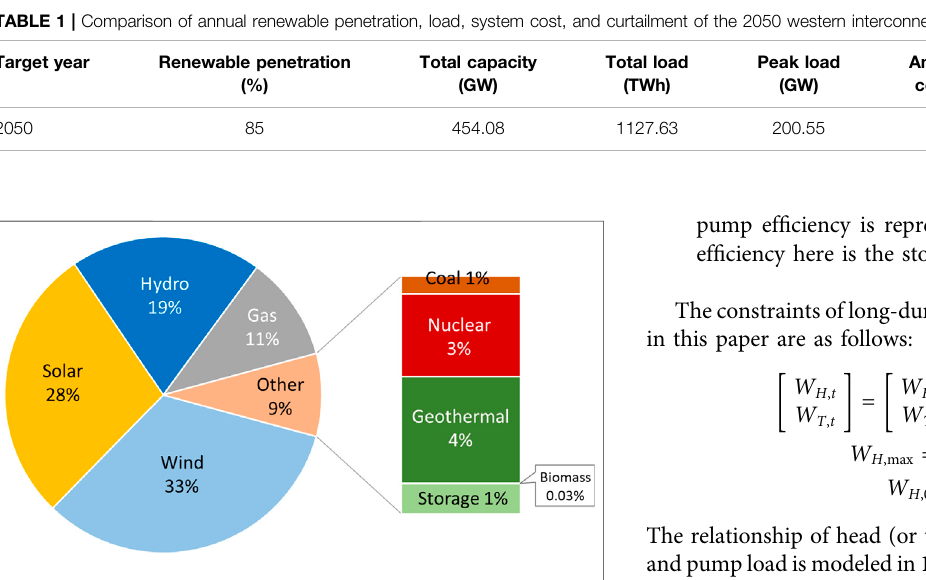
FIGURE 2 | Generation mix of western interconnection (WI) in 2050.